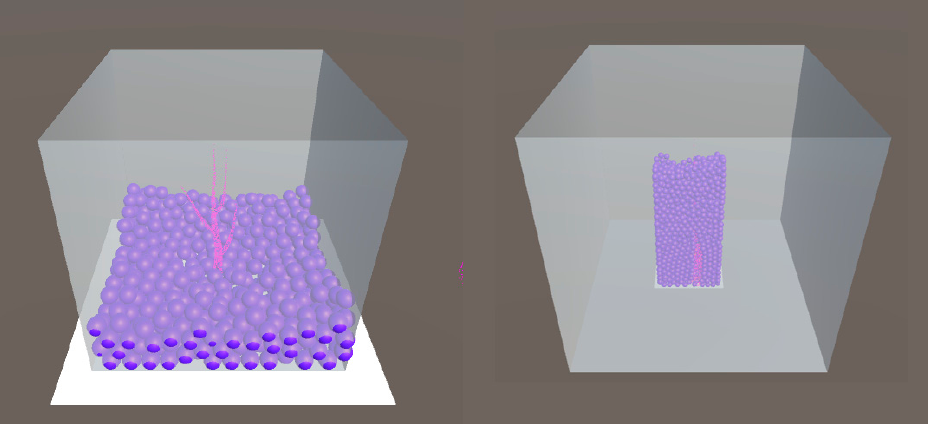
Figure 14. The VWD process for the artificial stem. ( Left ): The artificial point cloud in the standard cube vessel (side length = 400 cm) and VWMs (diameter = 29.136 cm); ( Right ): The artificial point cloud in a special cuboid (bottom length = 120 cm, bottom width = 60 cm, height = 300 cm) and VWMs (diameter = 10 cm).